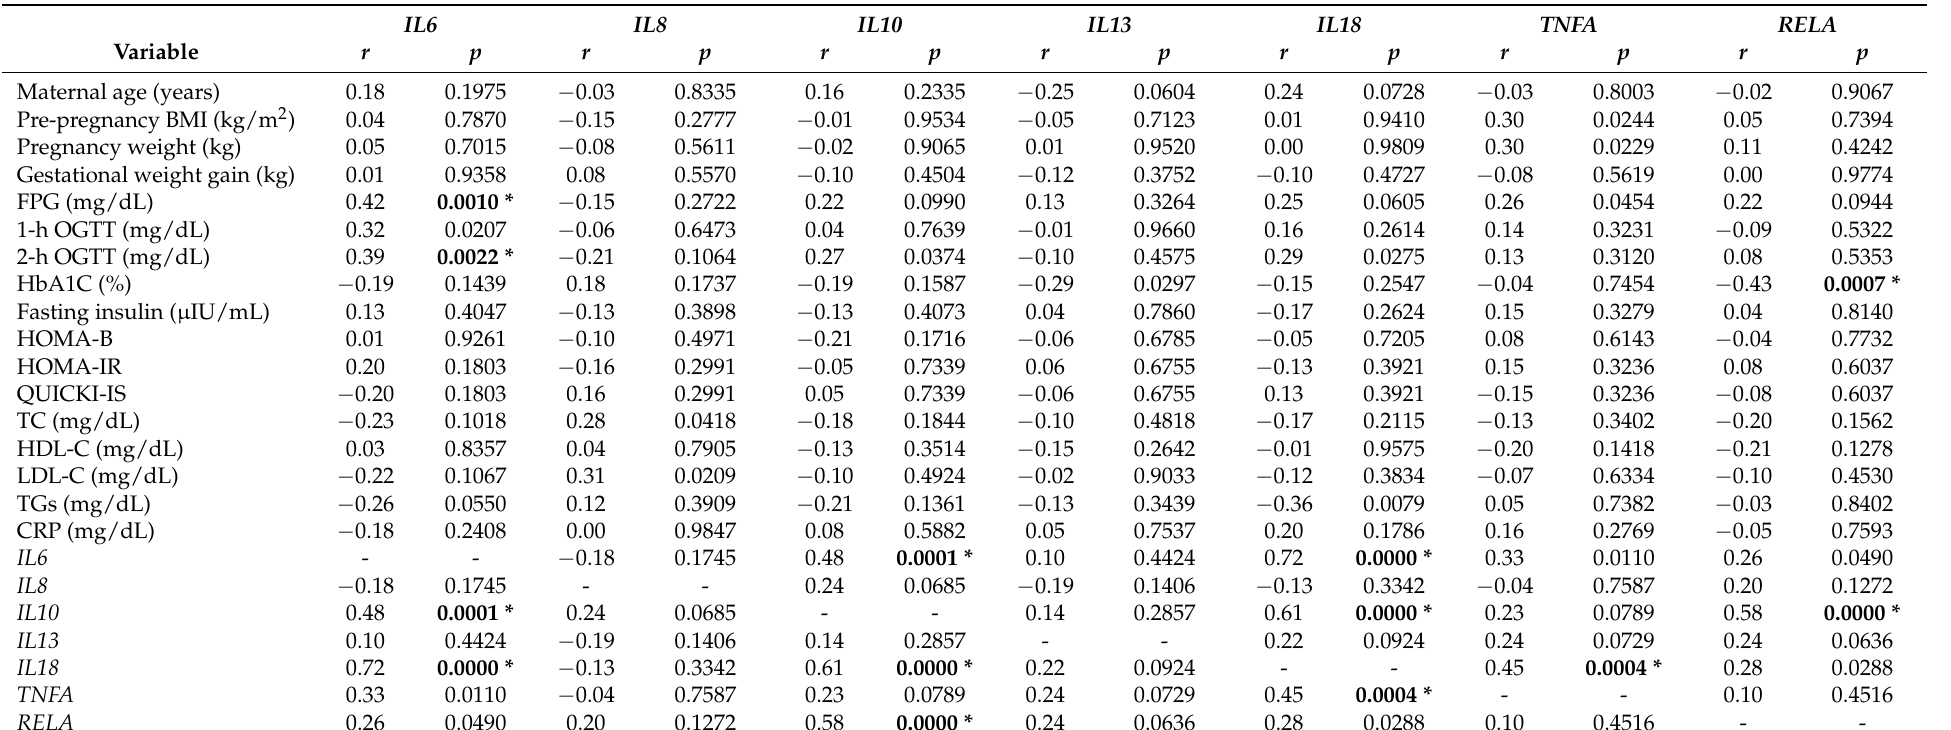
Table 3. Correlation study through Spearman’s linear regression analysis at GDM diagnosis ( n =